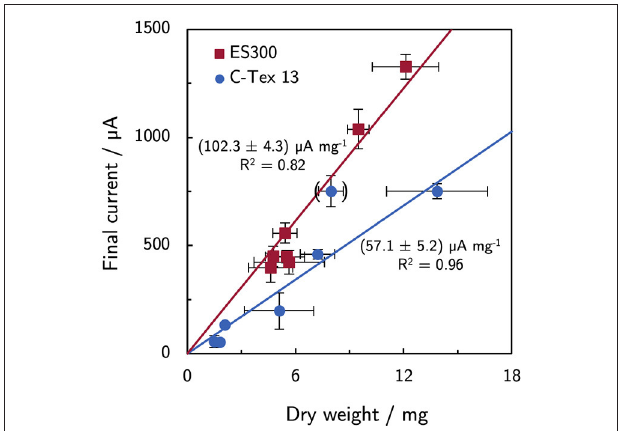
FIGURE 7 | Current and dry weight for all experimental conditions. ES300 enables a higher current production per biomass dry weight as compared to C-Tex 13. The value in brackets was excluded from the linear regression (C-Tex 13 with IM). The reasoning is discussed in the